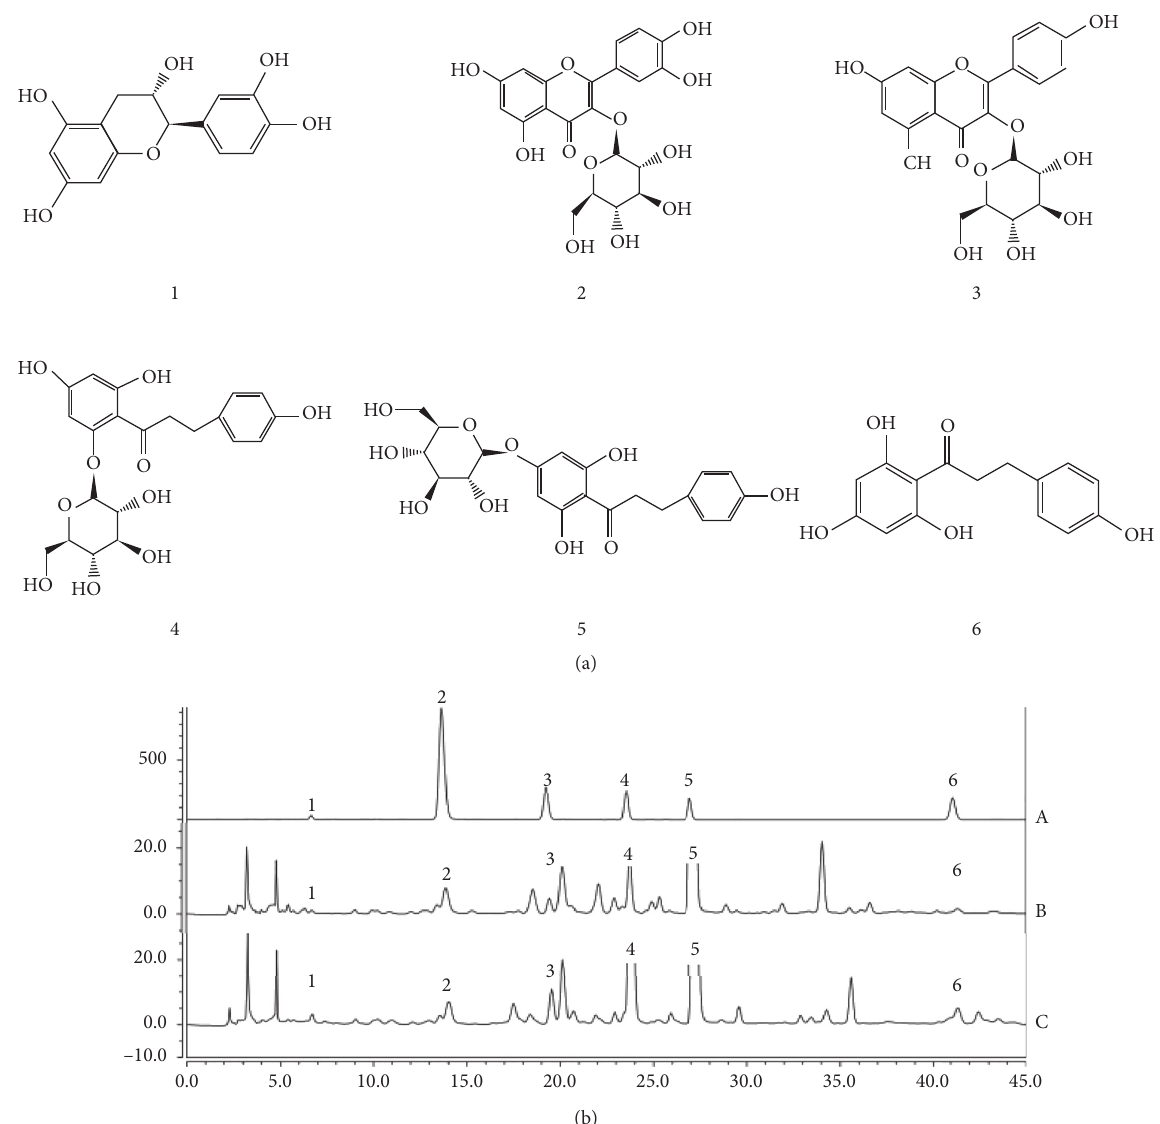
Figure 2: Structures of six chemicals and HPLC chromatograms of two parts of LP. (a) Structure of six chemicals. (1) Catechin, (2) isoquercetin, (3) astragalin, (4) phloridzin, (5) trilobatin, and (6) phloretin. (b) The HPLC chromatogram of six chemicals and LP samples. (A) The HPLC chromatogram of six chemicals. (B) The HPLC chromatogram of tender leaves of S1. (C) The HPLC chromatogram of flower spikes of S1. Peak identification: (1) catechin, (2) isoquercetin, (3) astragalin, (4) phloridzin, (5) trilobatin, and (6)